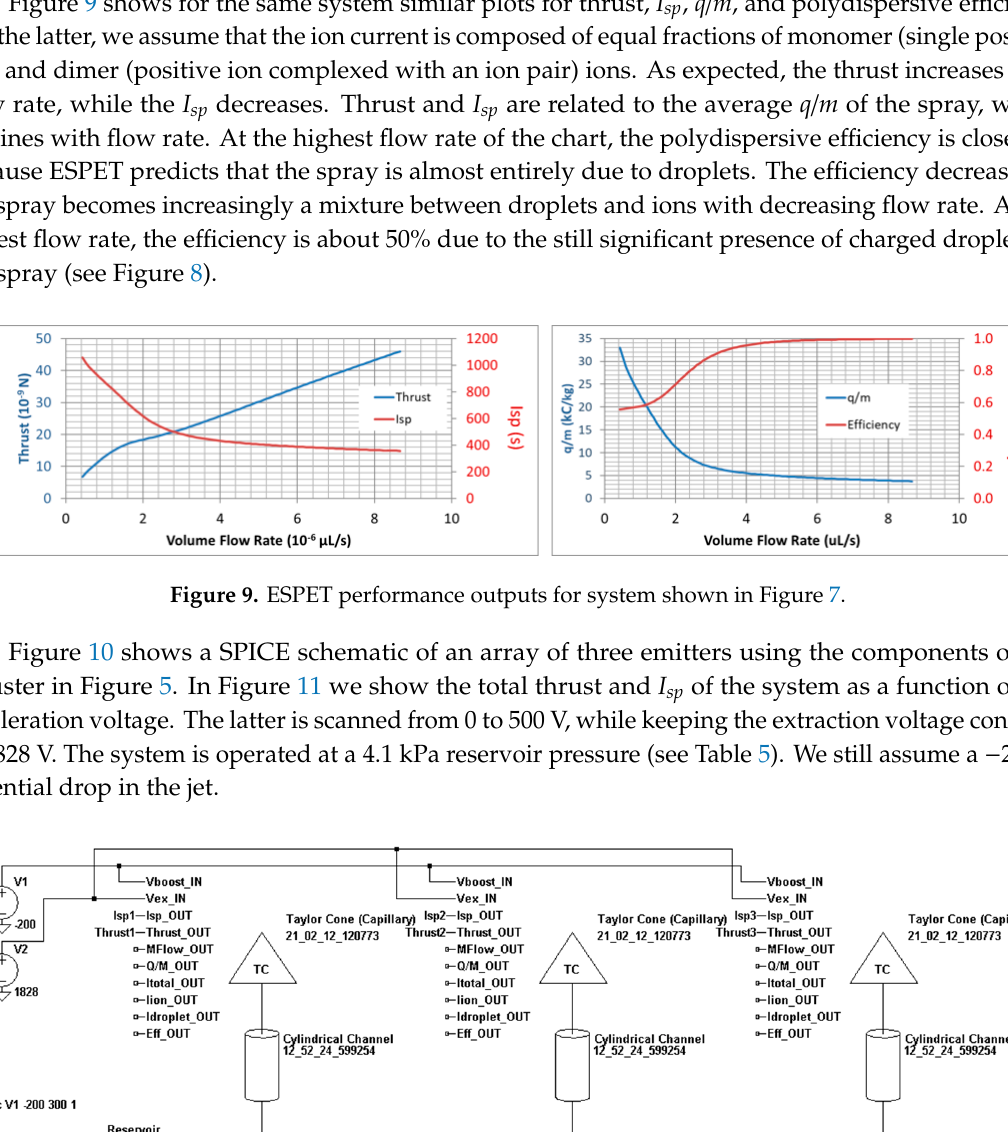
Figure 11. Total thrust and I sp versus acceleration (boost) voltage for 3 emitter array shown in Figure 10. When assigning tolerances to component parameters, the actual parameter value is set through a random number generator by LTspice reflecting the 1  tolerance. For example, the hydraulic resistances of the feed capillaries in the network of Figure 10 can be affixed a 10% tolerance. The user can then choose several Monte Carlo “trajectories” to compute the distribution of possible performance outcomes. Thus, ESPET in conjunction with the LTspice Monte Carlo feature is well suited for predictions of the emission uniformity of new electrospray array designs. In addition to a Monte Carlo analysis, LTspice also offers “worst ‐ case” analysis, where the network performance is computed at the extremes of component values specified with a tolerance. This provides for a more direct way of extracting quantitative information on the range of outputs of emitter components. 4.2. Passively Driven Capillary Emitter Array In this section, we apply both SPICE and QuickSolver solutions to the analysis of results obtained for a passively driven micro ‐ machined capillary emitter array operated on an EMI ‐ BF4 IL propellant, as reported by Dandavino et al. [1] of the Ecole Polytechnique Federale de Lausanne (EPFL). The array has a total of 127 emitters. The thruster was operated passively (i.e., the reservoir pressure was zero), and the flow was induced by the electric field. First, we compare the average emitter performance reported by Dandavino et al. to the outputs of a SPICE circuit for a single emitter shown in Figure 12. Two feed components are shown in Figure 12. The overall feed hydraulic resistance is dominated by the much narrower emitter inner diameter. The inner diameter of the emitter is quoted to be 7.9 ± 0.5 μ m. We adjusted the emitter extractor gap to match the onset voltage, and then adjusted a scaling factor, p scale , in Equation (9) to match the quoted mass flow. This resulted in p scale = 0.0085.